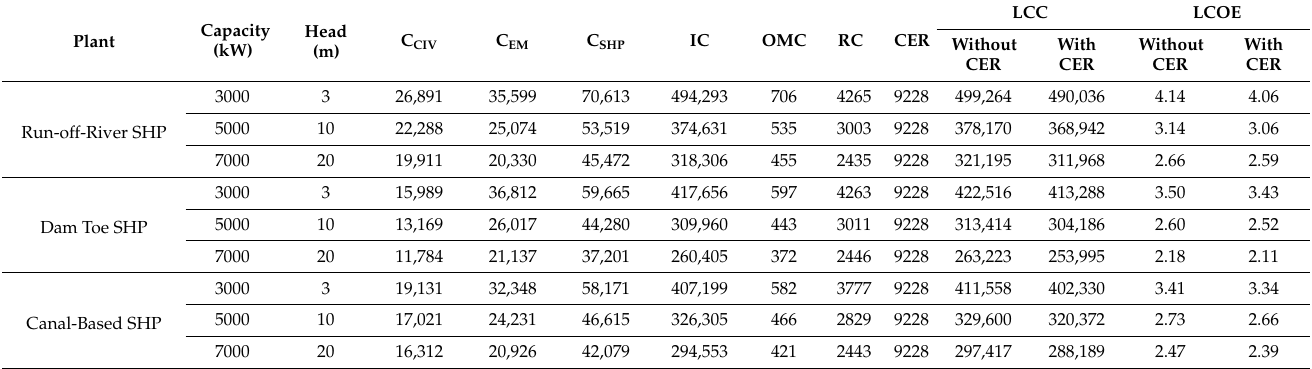
Table 5. LCOE values for low head SHP plants with and without CER.